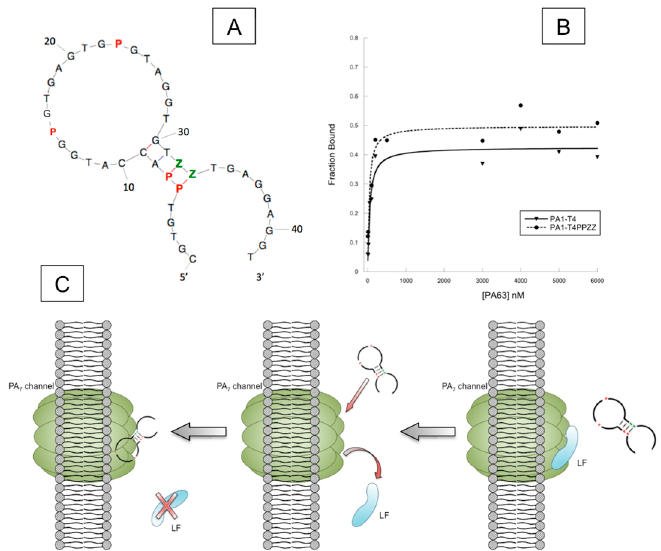
Figure 5. Anthrax protective antigen aptamer PA1T4PPZZ. ( A ) Aptamer’s predicted secondary structure and location of AEGIS nucleotides (in red, P, and green, Z). ( B ) Binding plots for PA1T4PPZZ and its parent molecule, PA1T4. ( C ) Graphical representation of an electrophysiology assay where PA63 in its channel conformation (green) is inserted into a membrane, and aptamer PA1T4PPZZ displaces the lethal factor (blue, LF) from its binding site on the channel.